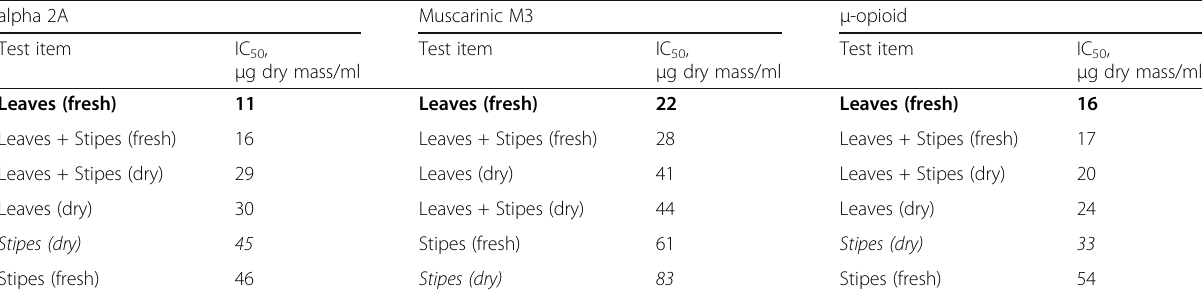
Table 2 Influence of the manufacturing process (Data table to Fig.